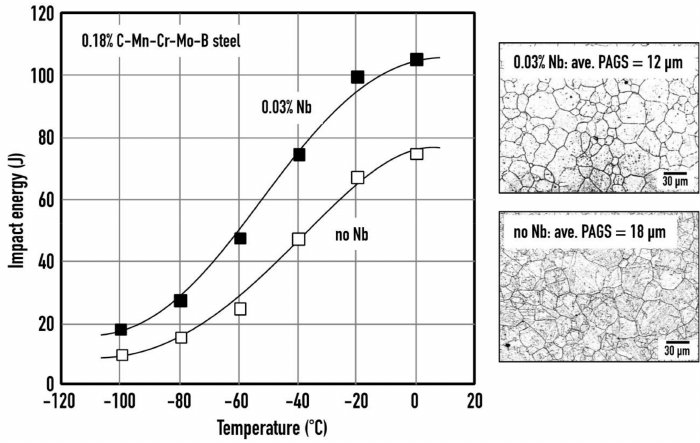
Figure 14. Influence of parent austenite grain refinement on ductile-to-brittle transition curves of HB450 abrasion resistant plate steel (0.18% C-Mn-Cr-Mo-B) produced by re-austenitizing